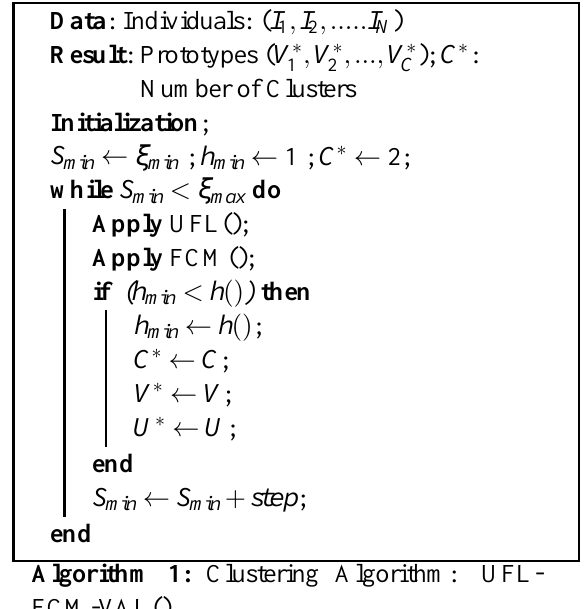
Algorithm 1: Clustering Algorithm: UFL-